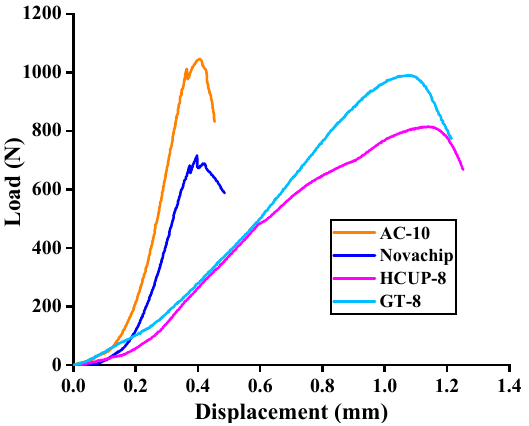
Figure 6. Load-displacement curve of low temperature bending test.